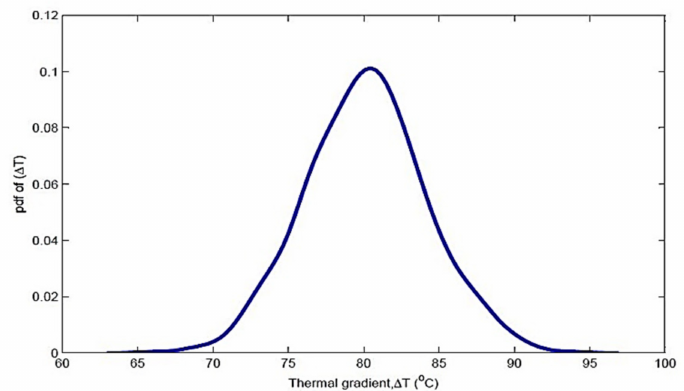
Figure 14. Nominal distribution of thermal gradient.